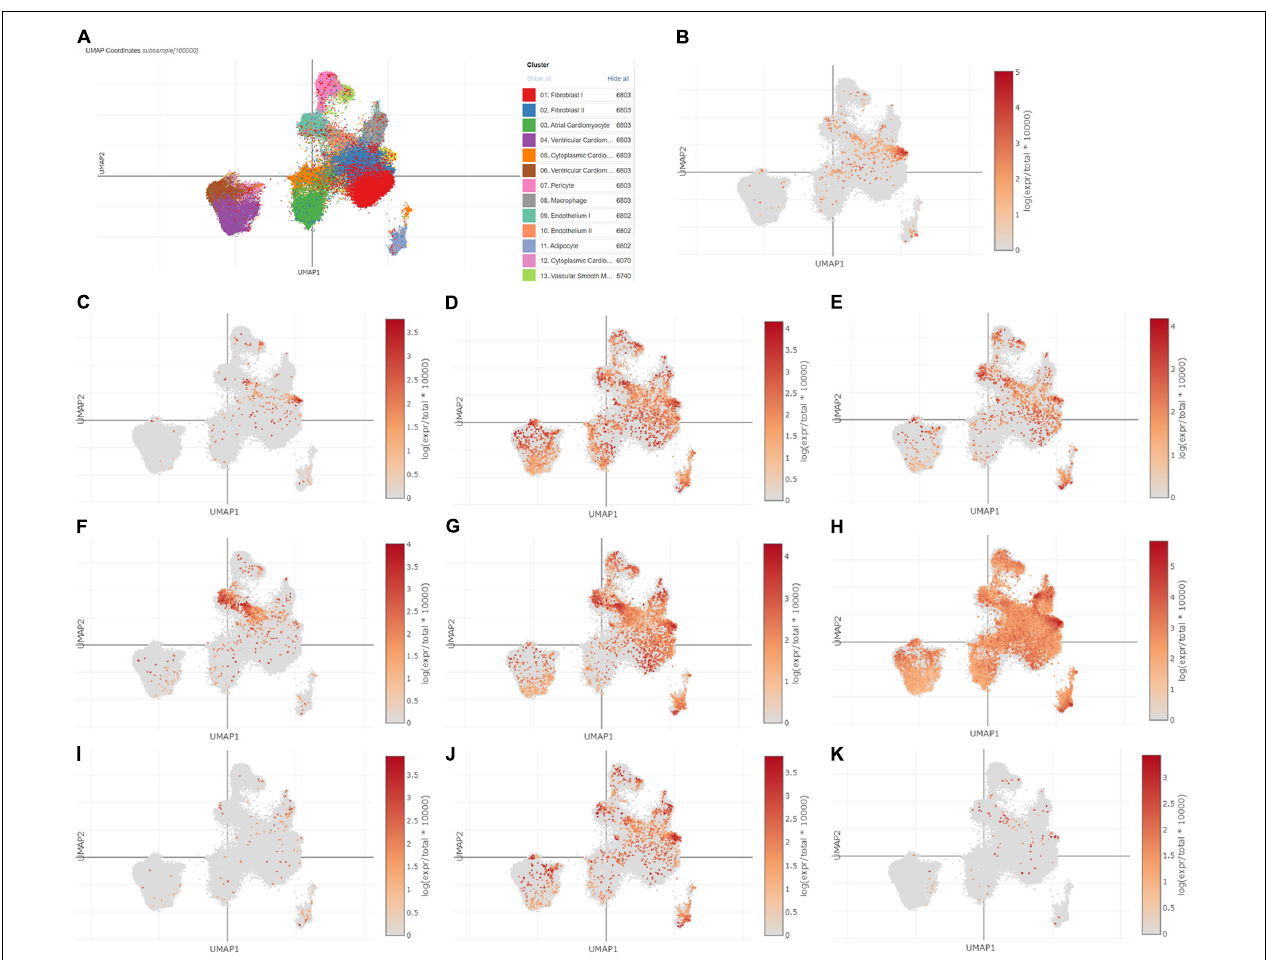
FIGURE 10 | The hub genes were highly expressed in the human heart. (A) The overall clustering of cells in the human heart. (B–K) The hub genes were validated to be highly expressed in the human heart, such as IL-6 (B) , PTGS2 (C) , JUN (D) , NQO1 (E) , NOS3 (F) , LEPR (G) , NAMPT (H) , CDKN2A (I) , CDKN1A (J) , and Snai1 (K)